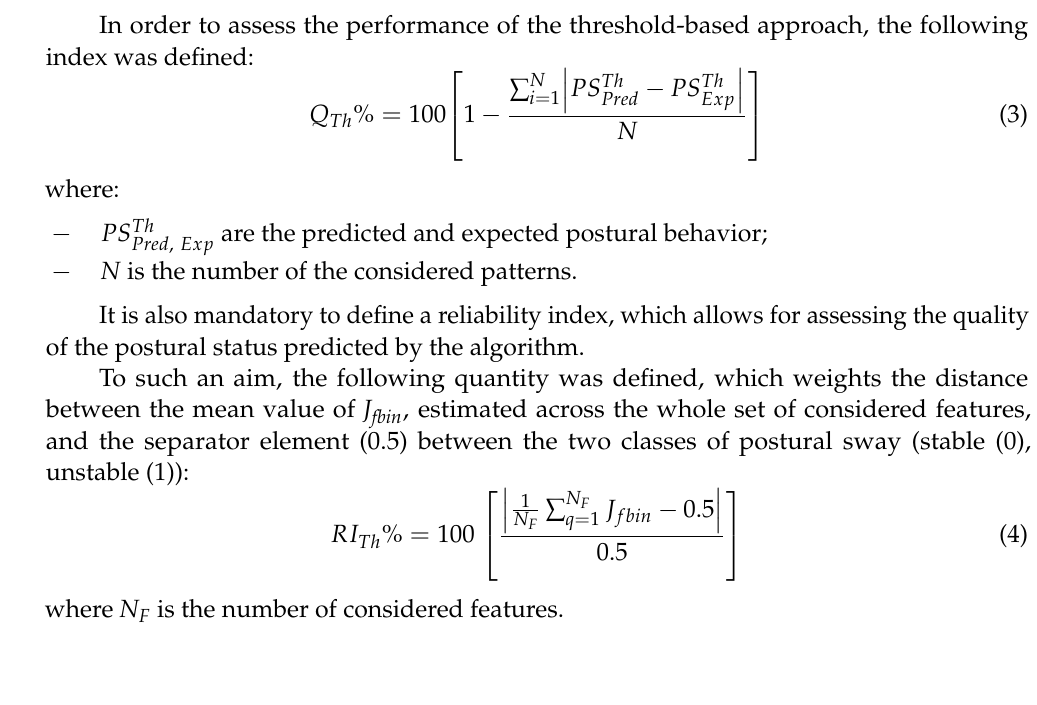
Figure 2. The threshold algorithm considered in this work to analyze the postural sway and to detect potential unstable behaviors [22].